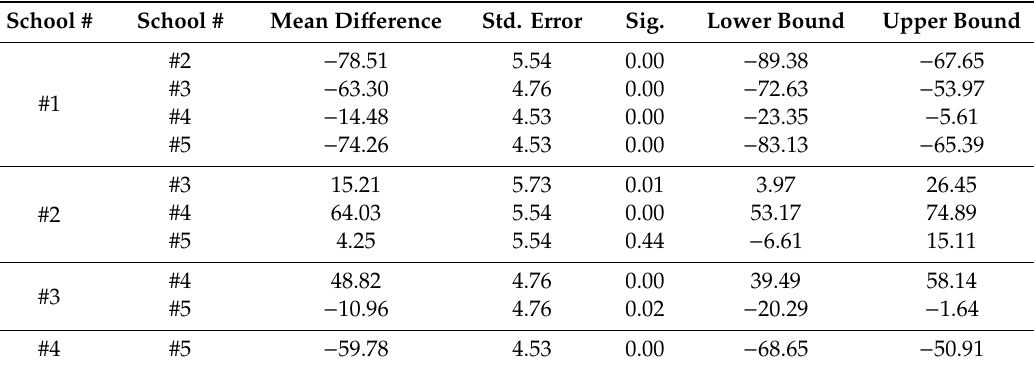
Table 10. Fishers LSD Analysis for CO 2 by School.